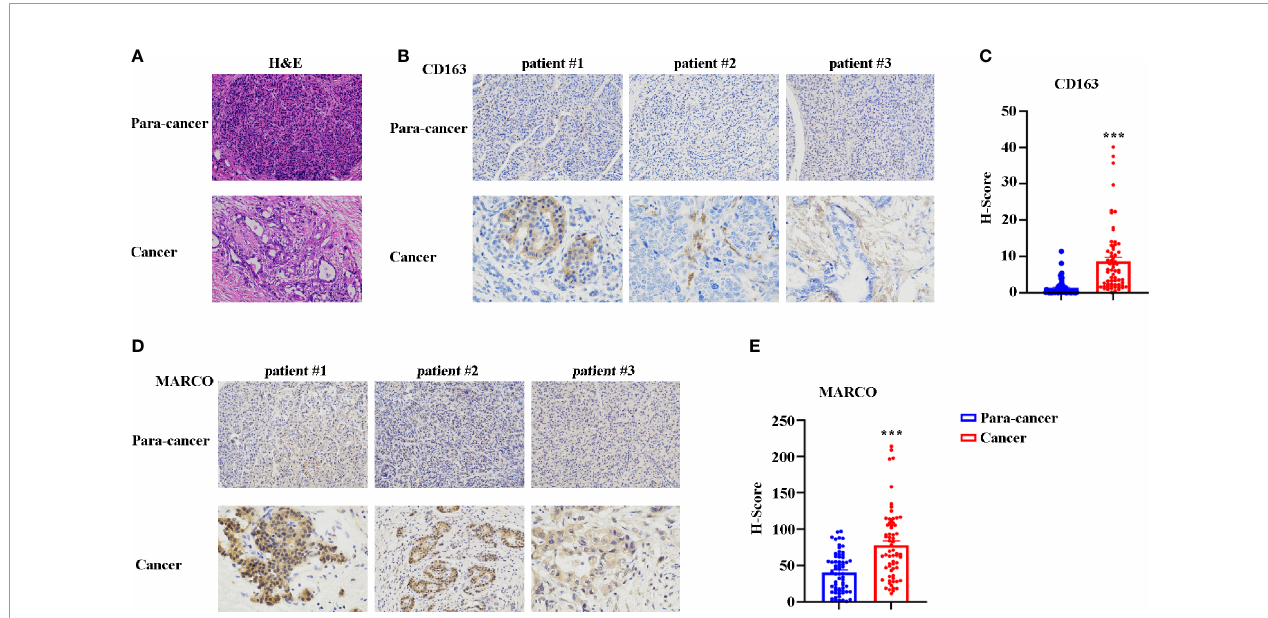
FIGURE 6 | The expression of CD163 and MARCO in pancreatic cancer examined using immunohistochemistry (IHC). (A) Representative HE staining of cancer tissue and paracancer tissue in pancreatic cancer. (B) Representative IHC image of CD163 in pancreatic cancer tissues and paracancer tissues. (C) Quantitative analysis of CD163 expression between pancreatic cancer tissues and paracancer tissues. (D) Representative IHC image of MARCO in pancreatic cancer tissues and paracancer tissues. (E) Quantitative analysis of MARCO expression between pancreatic cancer tissues and paracancer tissues. *** P < 0.001.